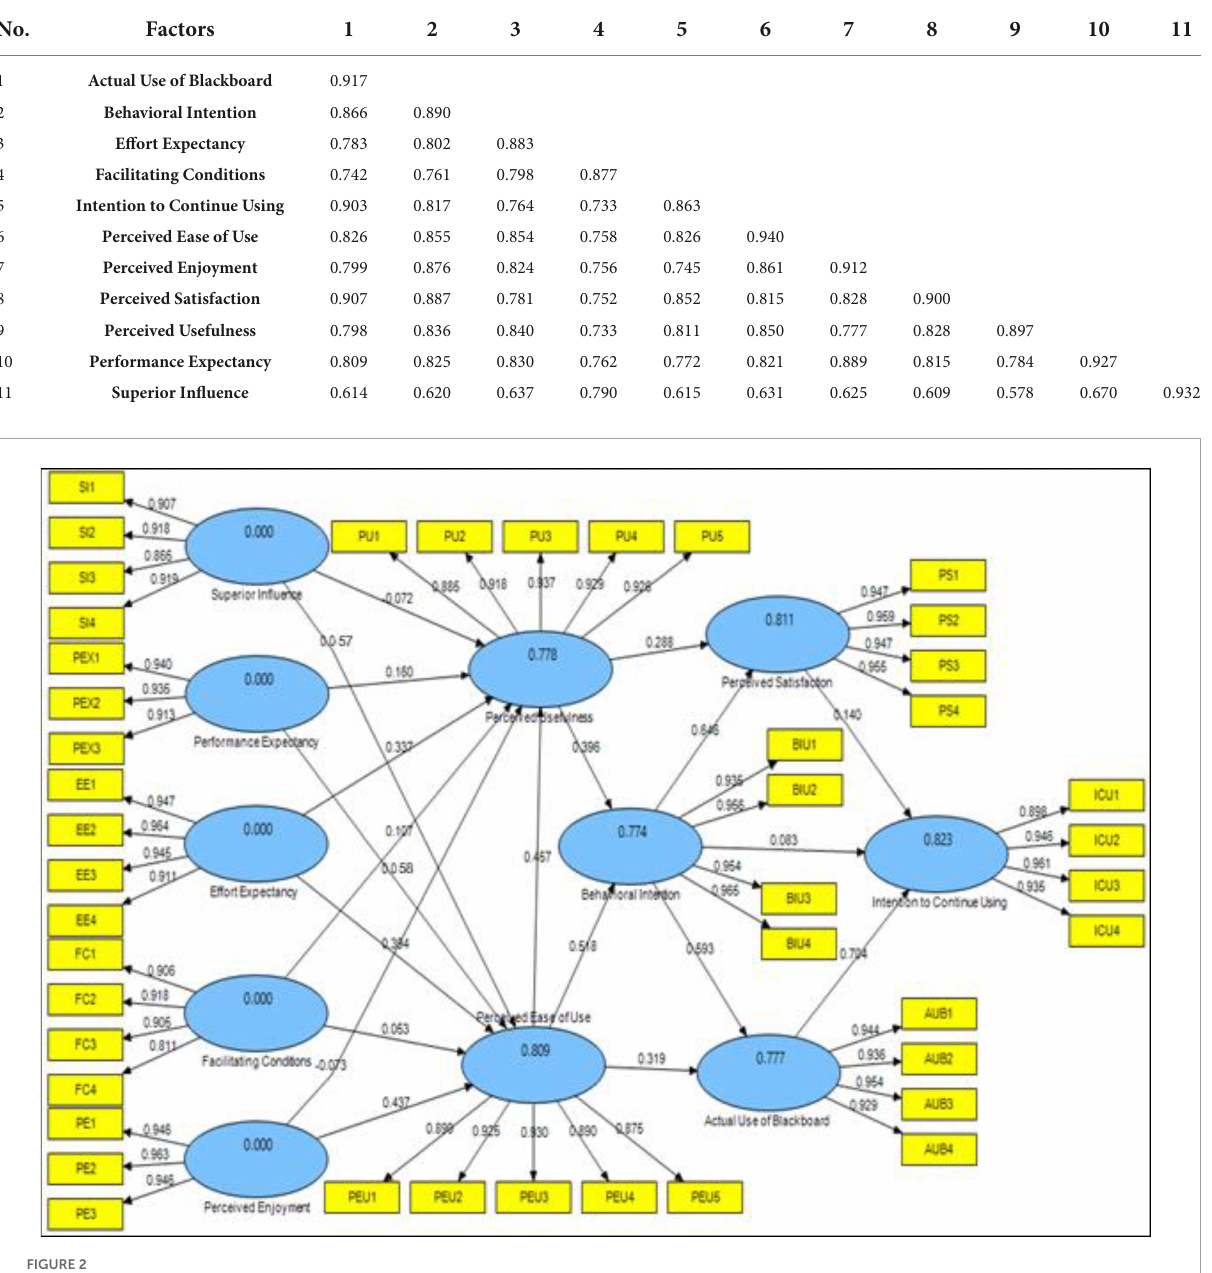
FIGURE2 Research